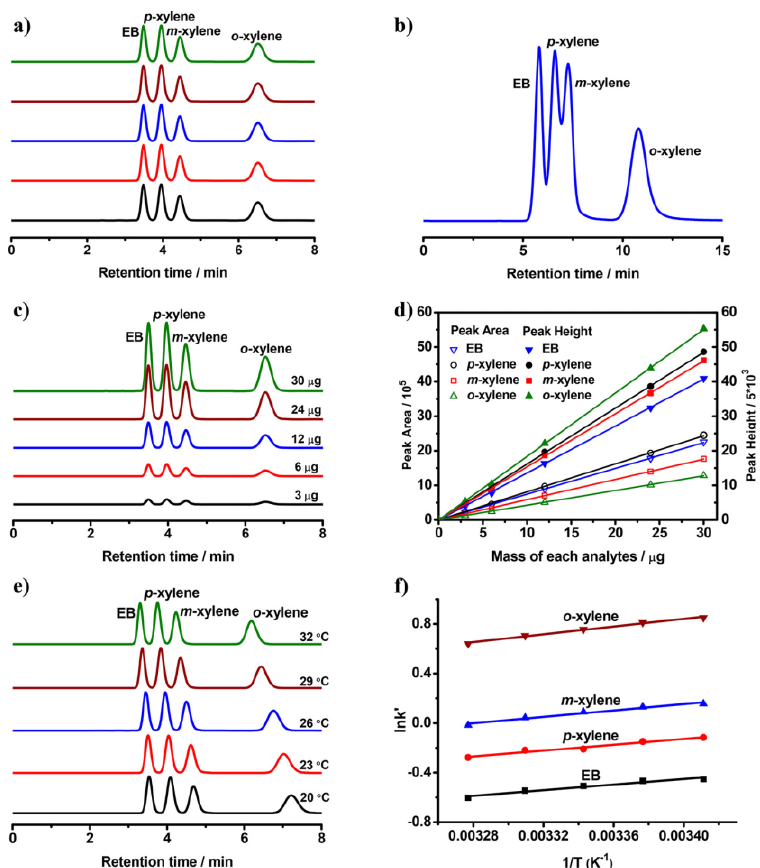
Figure 16. Salen-COFs for separation of C 8 alkyl-aromatics. Reprinted (adapted) with permission from [29]. Copyright {2019} American Chemical Society. ( a ) HPLC chromatograms of EB and xylene isomers on the COF 1 packed column for five replicate experiments; ( b ) HPLC chromatograms of EB and xylene isomers on the COF 1-Zn packed column; ( c ) HPLC chromatograms of EB and xylene isomers with different injected masses on the COF 1 packed column; ( d ) Effects of injected mass of EB and xylene isomers on the peak area and the peak height; ( e ) HPLC chromatograms of EB and xylene isomers on the COF 1 packed column at 20–32 °C; ( f ) Van’t Hoff plots for EB and xylene isomers. Analytes were analyzed at r t. using hexane and DCM ( v / v = 95:5) at a flow rate of 0.5 mL min −1 with UV detection at 254 nm.